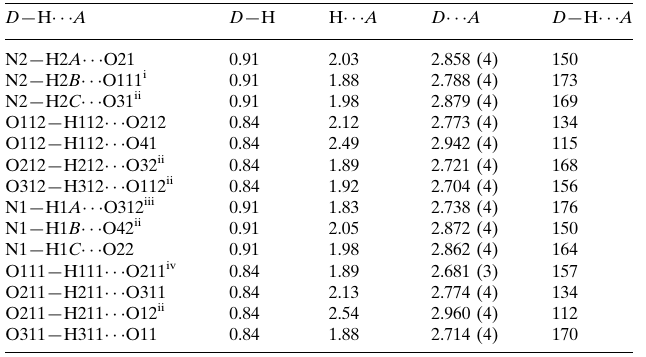
Hydrogen-bond geometry (A˚ , (cid:5)